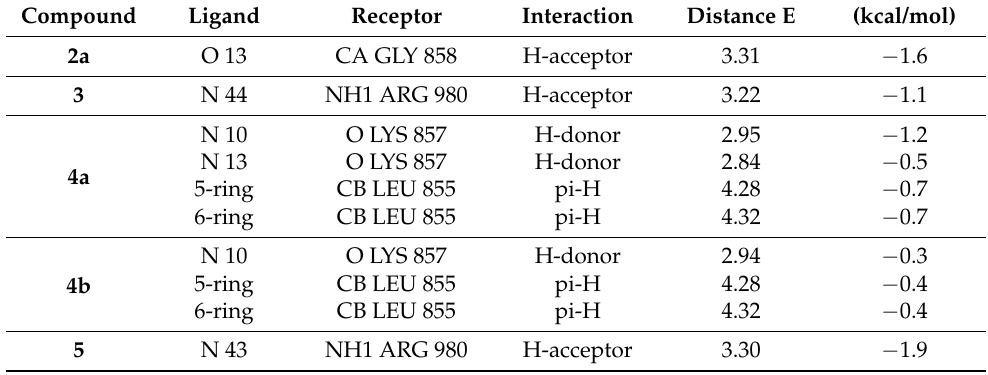
Table 6. Docking interaction of all compounds with MCF-7 breast docking result of “ 3 KRR ” protein.